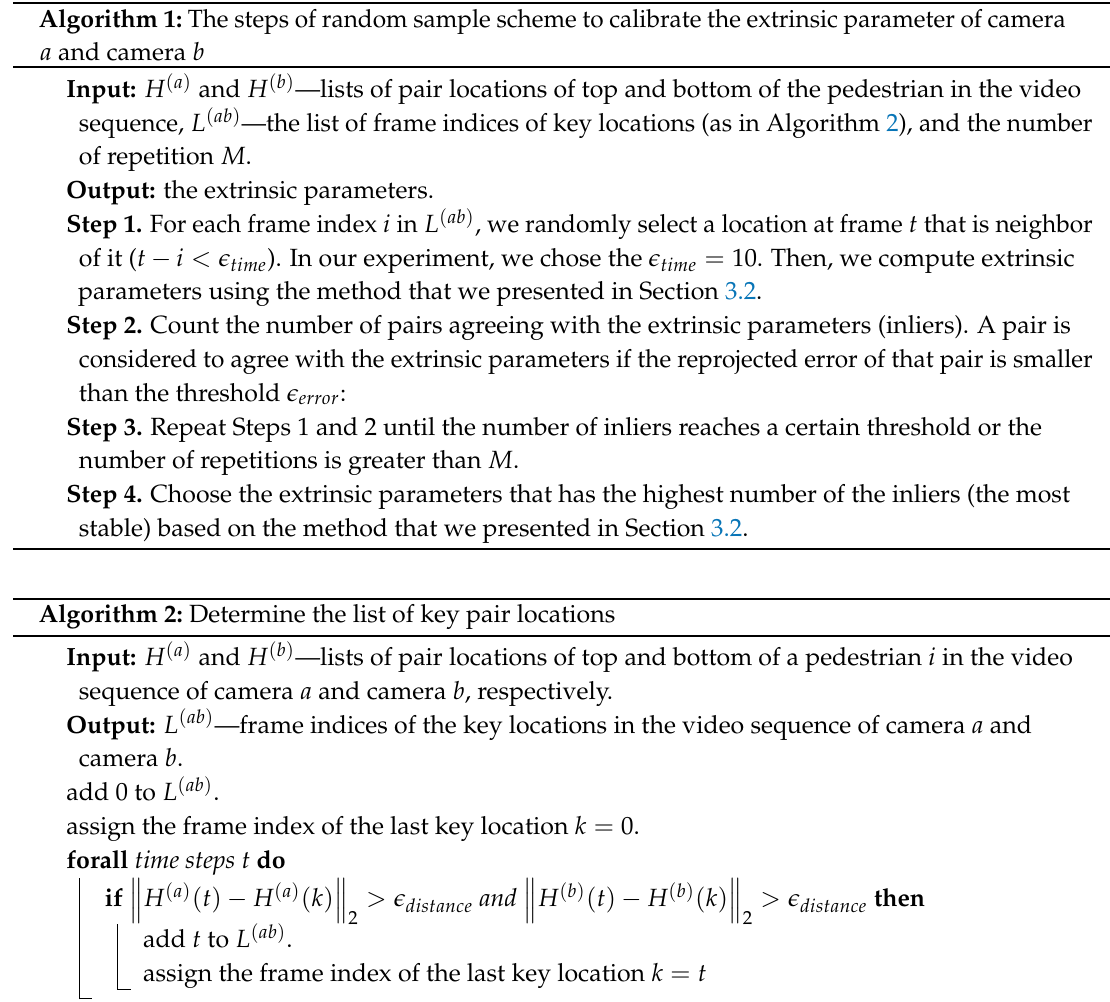
Algorithm 1: The steps of random sample scheme to calibrate the extrinsic parameter of camera a and camera b